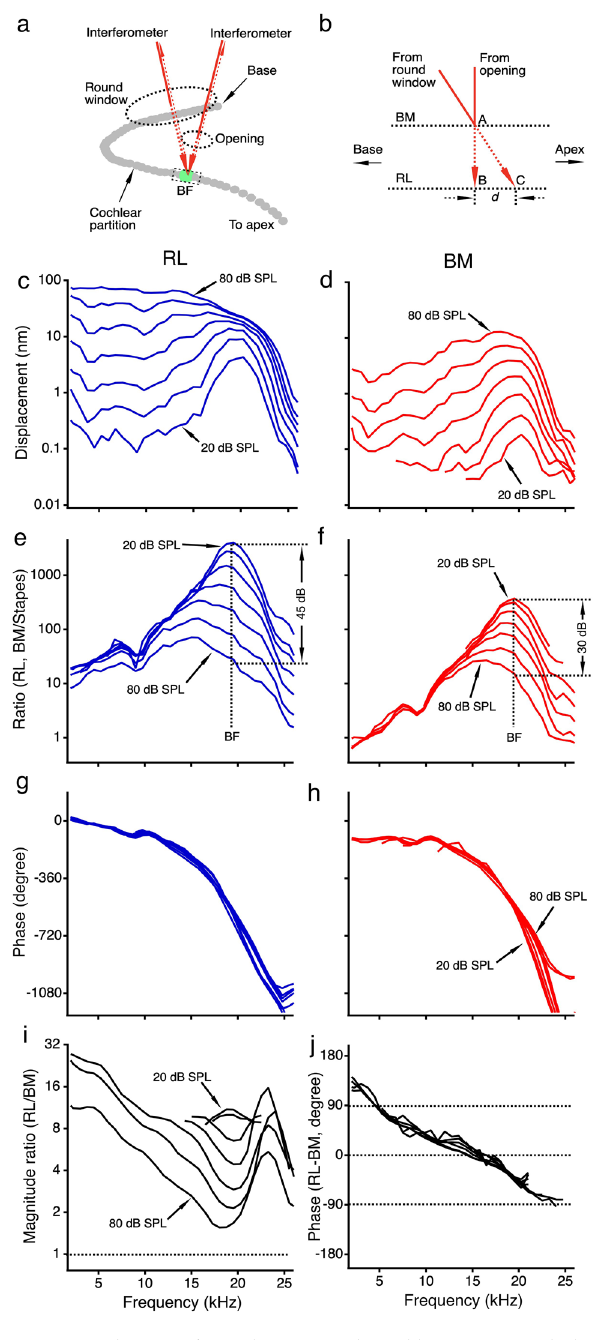
Figure 1. Schematic of optical accesses to the cochlear partition and vibrations of the reticular lamina and basilar membrane. ( a ) While the object beam of the interferometer accesses the cochlear partition through the round window in a non- perpendicular direction, it approaches the same best-frequency (BF) location through an opening in the cochlear lateral wall approximately in the transverse direction. ( b ) With a perpendicular optical axis, the object beam from the lateral wall opening reaches the BM and RL at the same longitudinal location (indicated by A and B in Fig. 1b). With a non-perpendicular optical axis, the object beam from the round window reaches the BM and RL at different longitudinal locations indicated by locations A and C. The time for a traveling wave to propagate over the distance between locations B and C can result in a phase difference between the RL and BM vibration. ( c , d ), The magnitude spectra of the RL and BM vibrations presented by displacements as a function of frequency at different sound pressure levels. ( e , f ) Transfer functions of the RL and BM vibrations presented by the ratio of the RL or BM displacement to the stapes displacement as a function of frequency at different sound pressure levels. ( g , h ) The phase spectra of the RL and BM vibrations shown by phase difference obtained by subtracting the stapes phase from the RL or BM phase as a function of frequency at different sound pressure levels. ( i ) Magnitude difference between the RL and BM vibration displayed by the ratio of the RL displacement to the BM displacement as a function of frequency at different sound pressure levels. ( j ) The phase difference between the RL and BM vibration obtained by subtracting the BM phase from the RL phase as a function of frequency at different sound